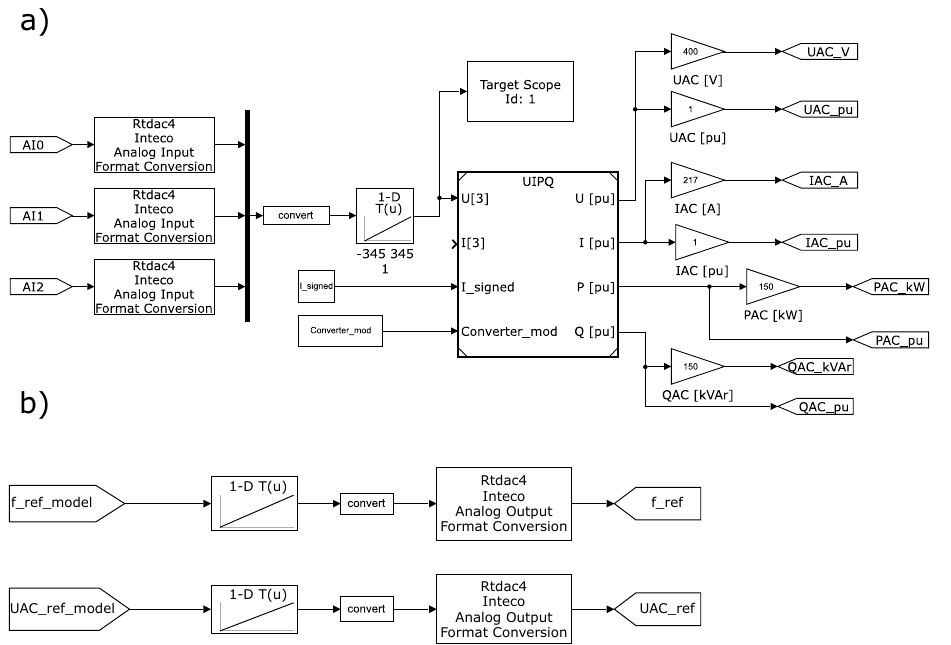
Figure 3. ( a ) Example of input signal path present in the FUC algorithm for the calculation of RMS voltages, currents, active and reactive power; ( b ) example of the analogue output scaling and conver- sion for the reference values of phase voltage and converter frequency within the FUC algorithm.